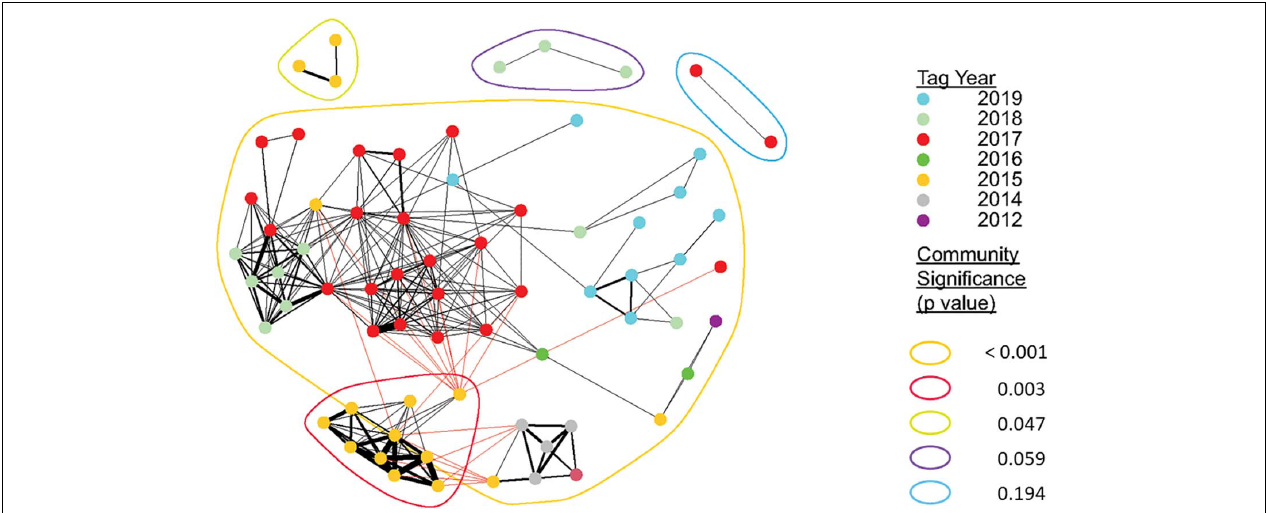
FIGURE 3 | Sociogram showing associations of all tagged juvenile white sharks across all years. Nodes represent individual sharks, node color indicates the year in which they were detected or formed strongest associations (in the case of sharks detected over more than year). Edge thickness indicates the relative number of connections (associations) between nodes. Colors encircling multiple nodes represent identified distinct communities. Detected sharks that did not form dyadic connections to at least one other tagged shark ( n = 31) are not shown. Community modularity for all detections across all years was high ( Q = 0.63), which reflects that although communities appear to be connected, they were spatiotemporally distinct with limited individual connections to other communities.